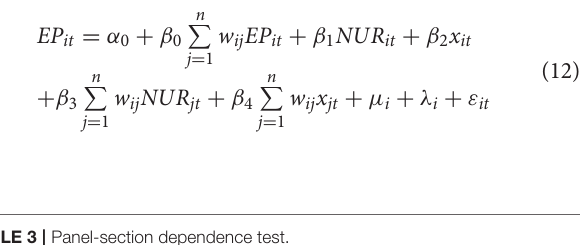
TABLE 3 | Panel-section dependence test.